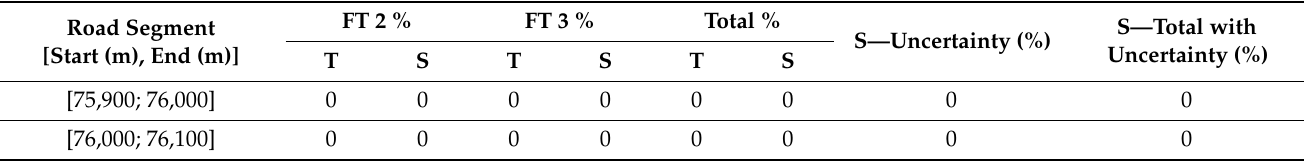
Table 7. Crack percentages: FT 2—crack severity level 2; FT 3—crack severity level 3; T—Tecnofisil results; S—system